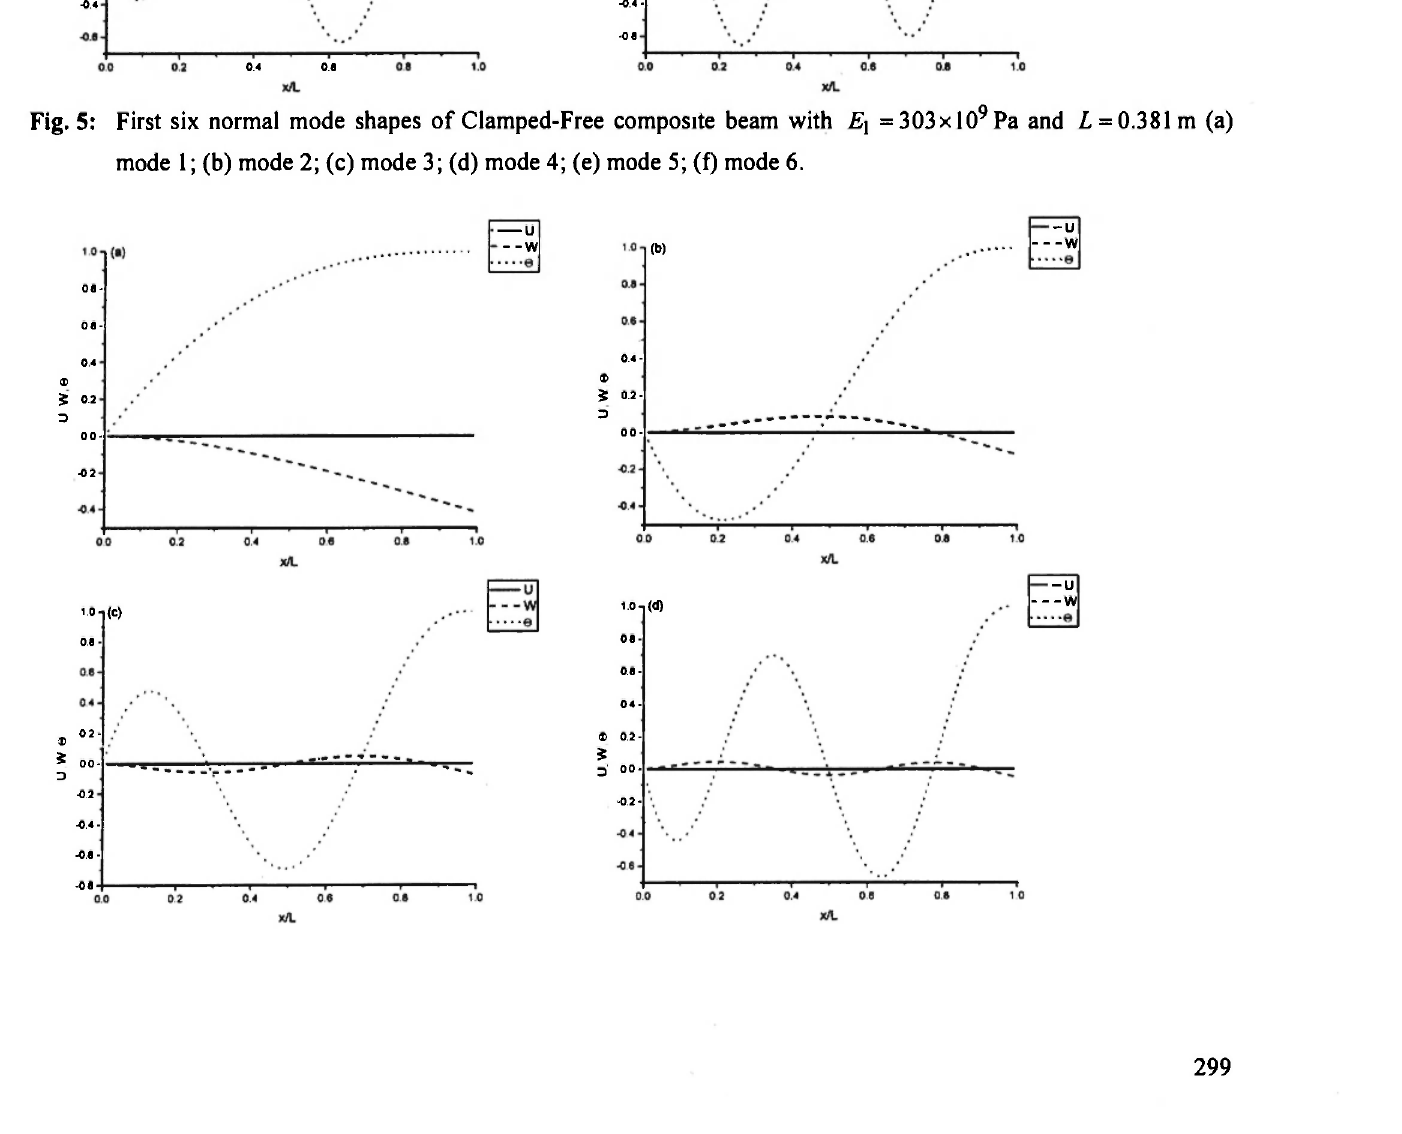
Fig. 5: First six normal mode shapes of Clamped-Free composite beam with £j =303xl0 9 Pa and L = 0.381 m